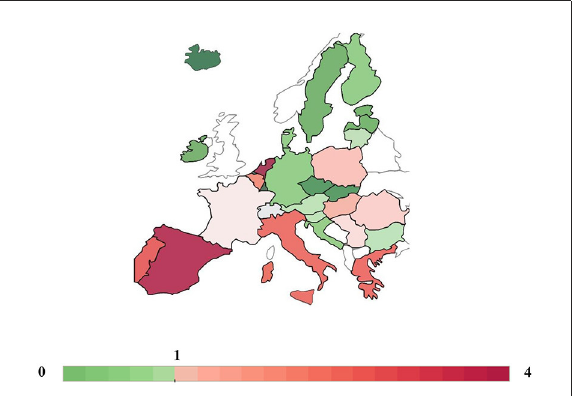
FIGURE1 Identification of the exporting (red) and domestic-supply (green) countries in the European community based on the relationship between the consumption per capita of vegetables (excluding potatoes) in Europe (EEA, 2017) and the amount of product harvested per person in 2020 (EUROSTAT, 2020) (author